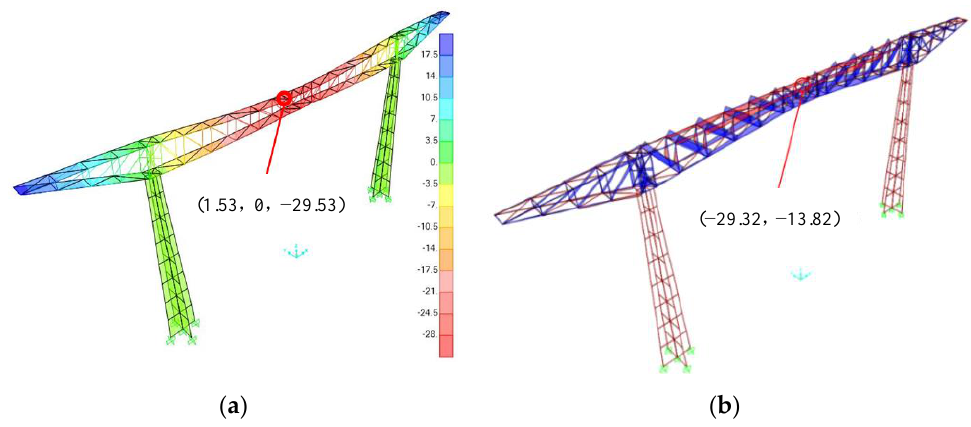
Figure 7. Condition 4. ( a ) Deformation pattern. ( b ) Stress diagram.